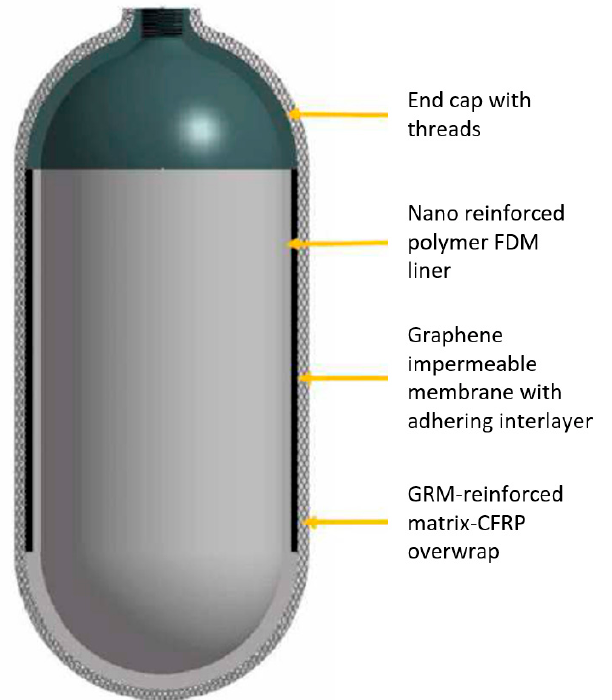
Figure 13. High-performance and lightweight Graphene-CFRP compressed hydrogen storage tanks [73].